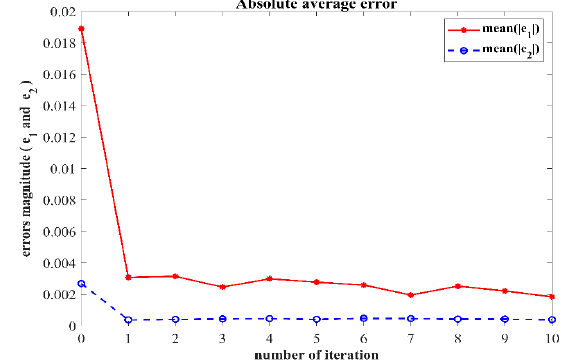
Figure 11. Iterative convergence trend.